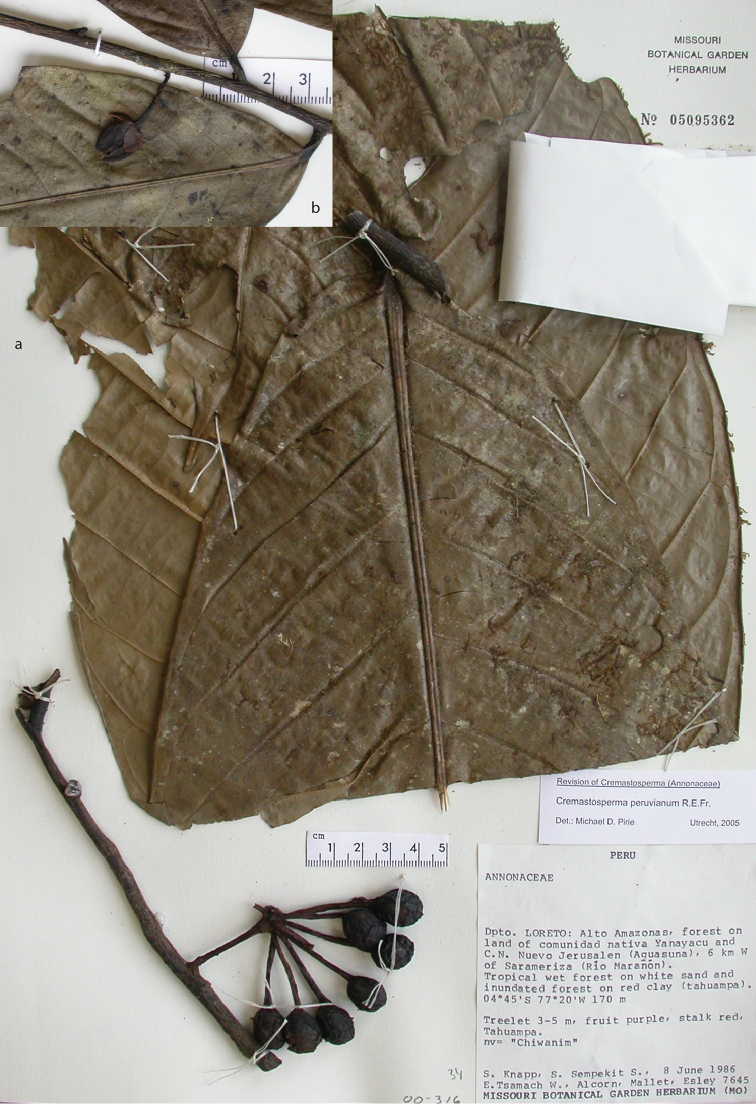
Cremastospermaperuvianum R.E.Fr. a fruiting specimen b flower bud (aKnapp et al. 7645bDíaz et al. 8225).